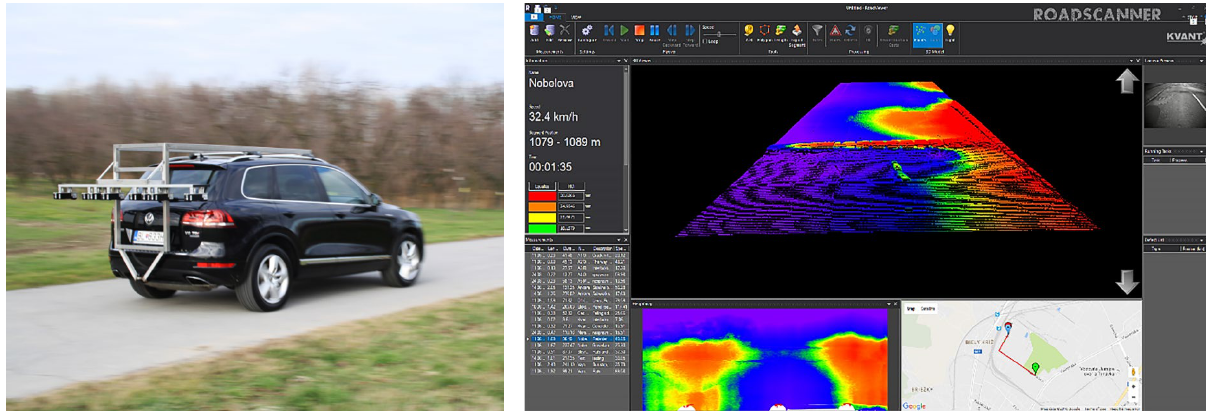
Figure 5. DRS (by KVANT – UNIZA) and workspace of measuring and evaluating software